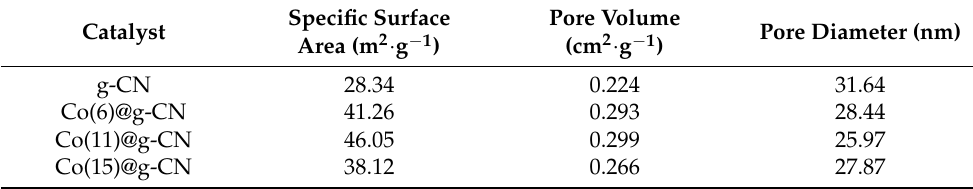
Figure 4. ( a ) Nitrogen adsorption-desorption isotherms of g-CN and Co(x)@g-CN (x = 6, 11, 15) and ( b ) their respective BJH plots. Table 1. Nitrogen adsorption-desorption isotherm analyses of different catalysts.